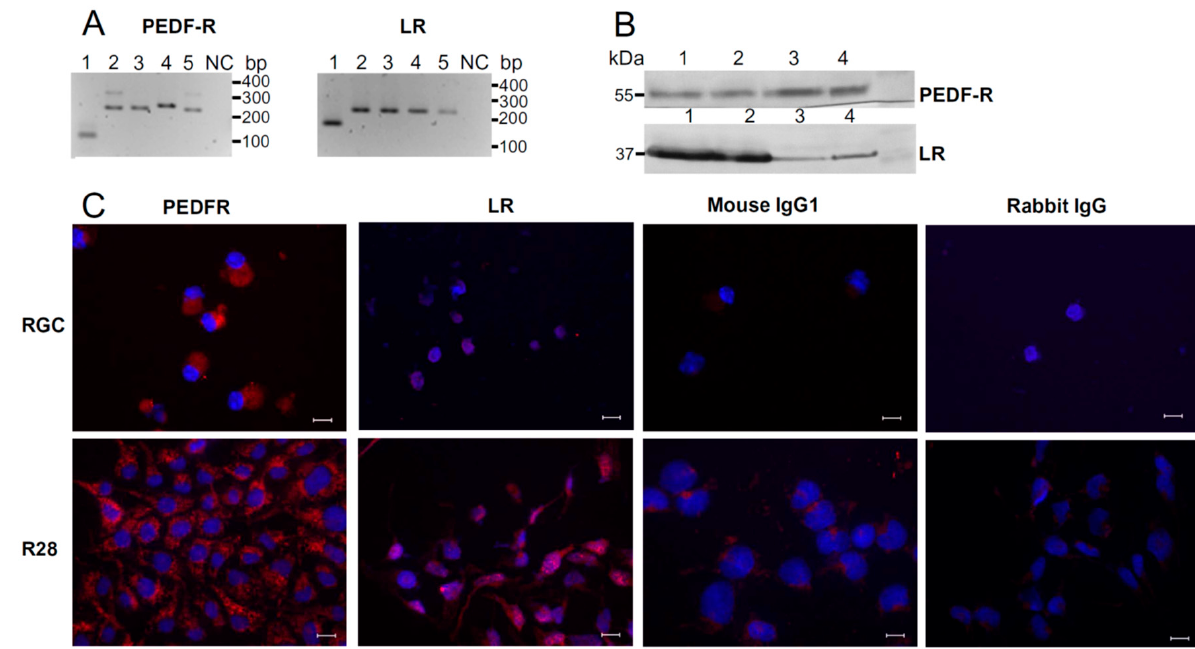
Figure 1. Primary retinal ganglion cells (RGC) and R28 cells express PEDF-R and laminin receptor (LR). ( A ) Total RNA was extracted from RGC (1) and R28 cells (2) and mRNA expression was examined by reverse transcription (RT)-PCR. For comparison, mRNA expression of both PEDF receptors in rat Müller (3), ARPE-19 (4) and human retinal pigment epithelium (RPE) cells (5) is demonstrated (NC: negative PCR control). ( B ) Western blot analysis revealed PEDF-R and LR expression in human RPE (1), ARPE-19 (2), rat Müller (3) and R28 cells (4). Blots were probed with antibodies against PEDF-R and LR. ( C ) Immunofluorescence of RGC and R28 cells generated by antibody labeling was detected using microscopic imaging ( red fluorescence: PEDF-R and LR). Negative controls using non-immune mouse IgG1 or rabbit IgG were included. Cell nuclei were labeled with DAPI ( blue fluorescence). Scale bars, 10 µm.